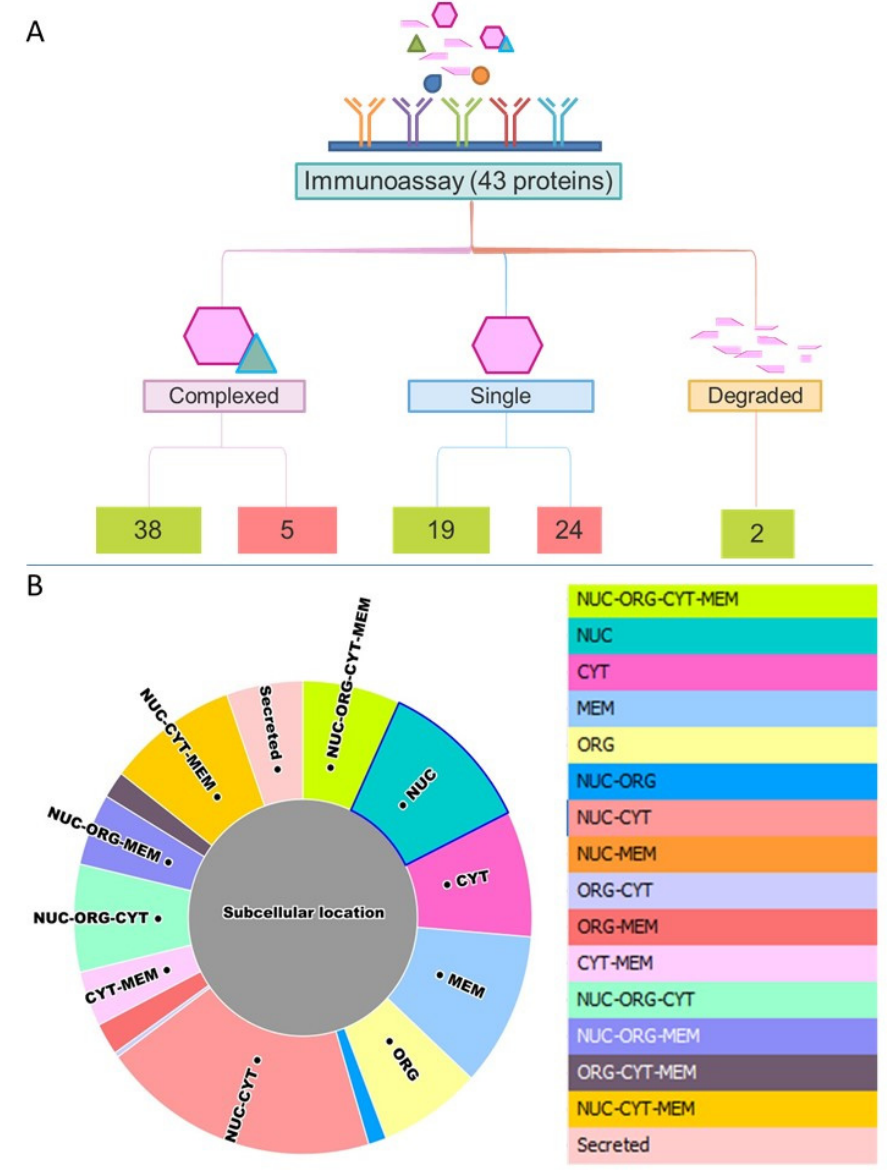
Figure 3. Summary of interest proteins selected for integration of SEC-MAP in the analysis of intracellular signaling pathways. ( A ) : Schematic representation of proteins globally observed at different molecular isoforms (monomer, complexed, degraded). In green, the number of proteins detected, and in red, the number of non-detected proteins. ( B ): Summary pie chart of theoretical subcellular localization of proteins globally detected by all protein extraction protocols.